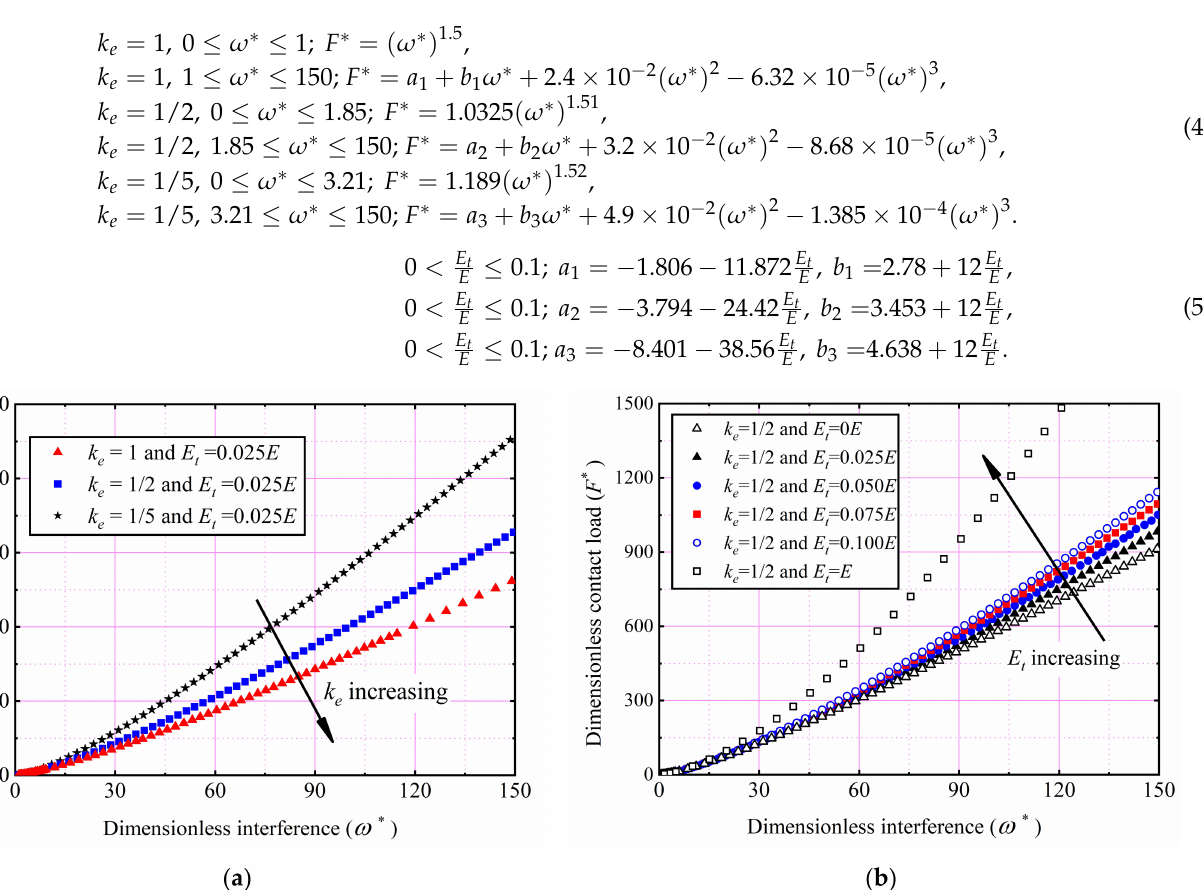
Figure 4. Evolution of F * with increasing ω * : ( a ) under different values of k e ; ( b ) under different values of E t